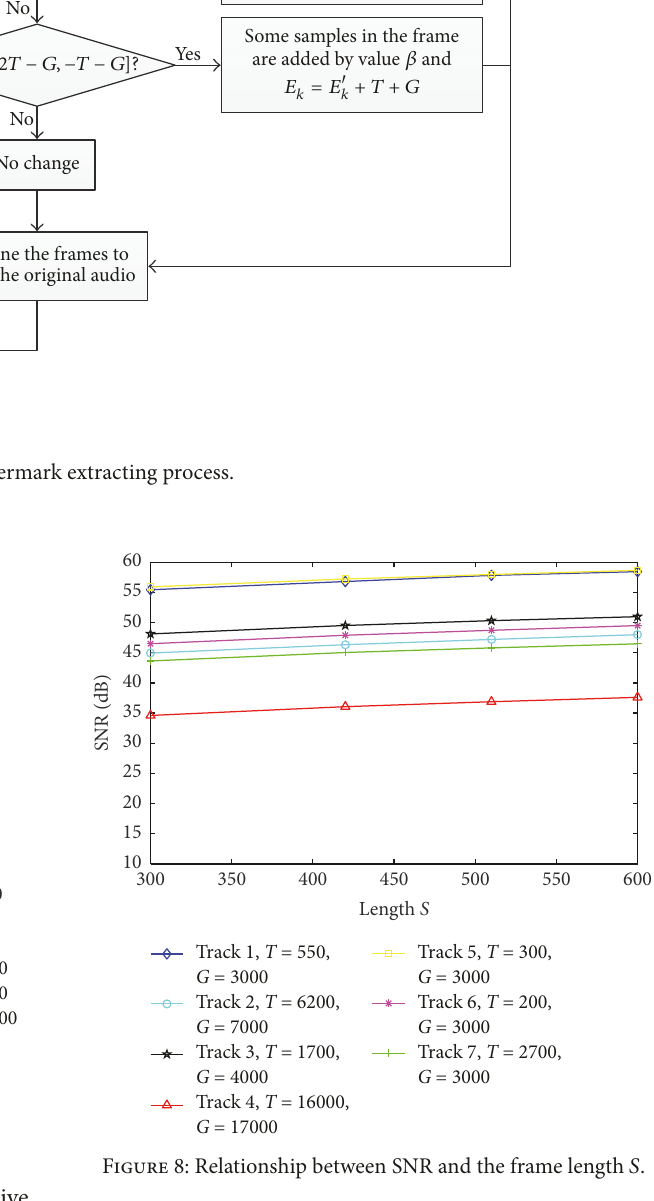
MP3 compression of 48 Kbps. The robustness against additive noise is also satisfactory. Even with the noise intensity at 25 dB, the BER (bit error rate) values are less than 10% except for track 1 . Besides, the watermark robustness against resampling and requantization operations is perfect, and the hidden bits can be recovered without errors.